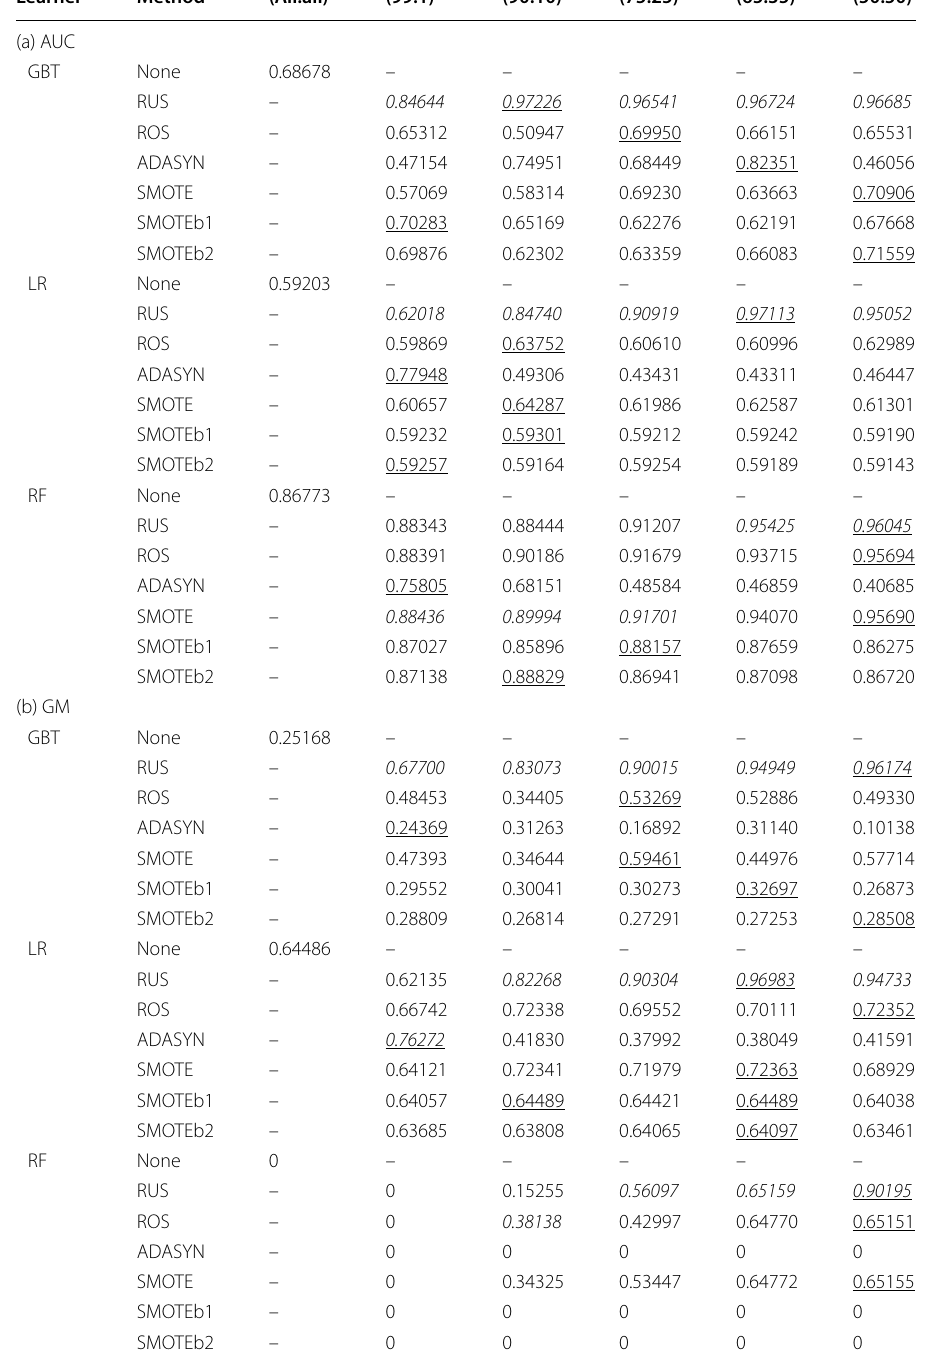
Table 5 Case 2: SlowlorisBig